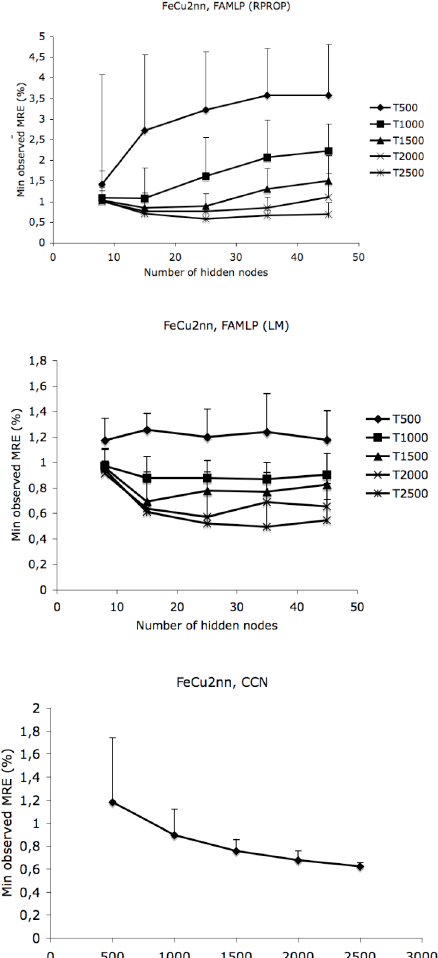
Fig. 11. FeCu2nn trained with FAMLP and CCN. The error bars show the max observed MRE over the 20 trainings performed. T is the number of training